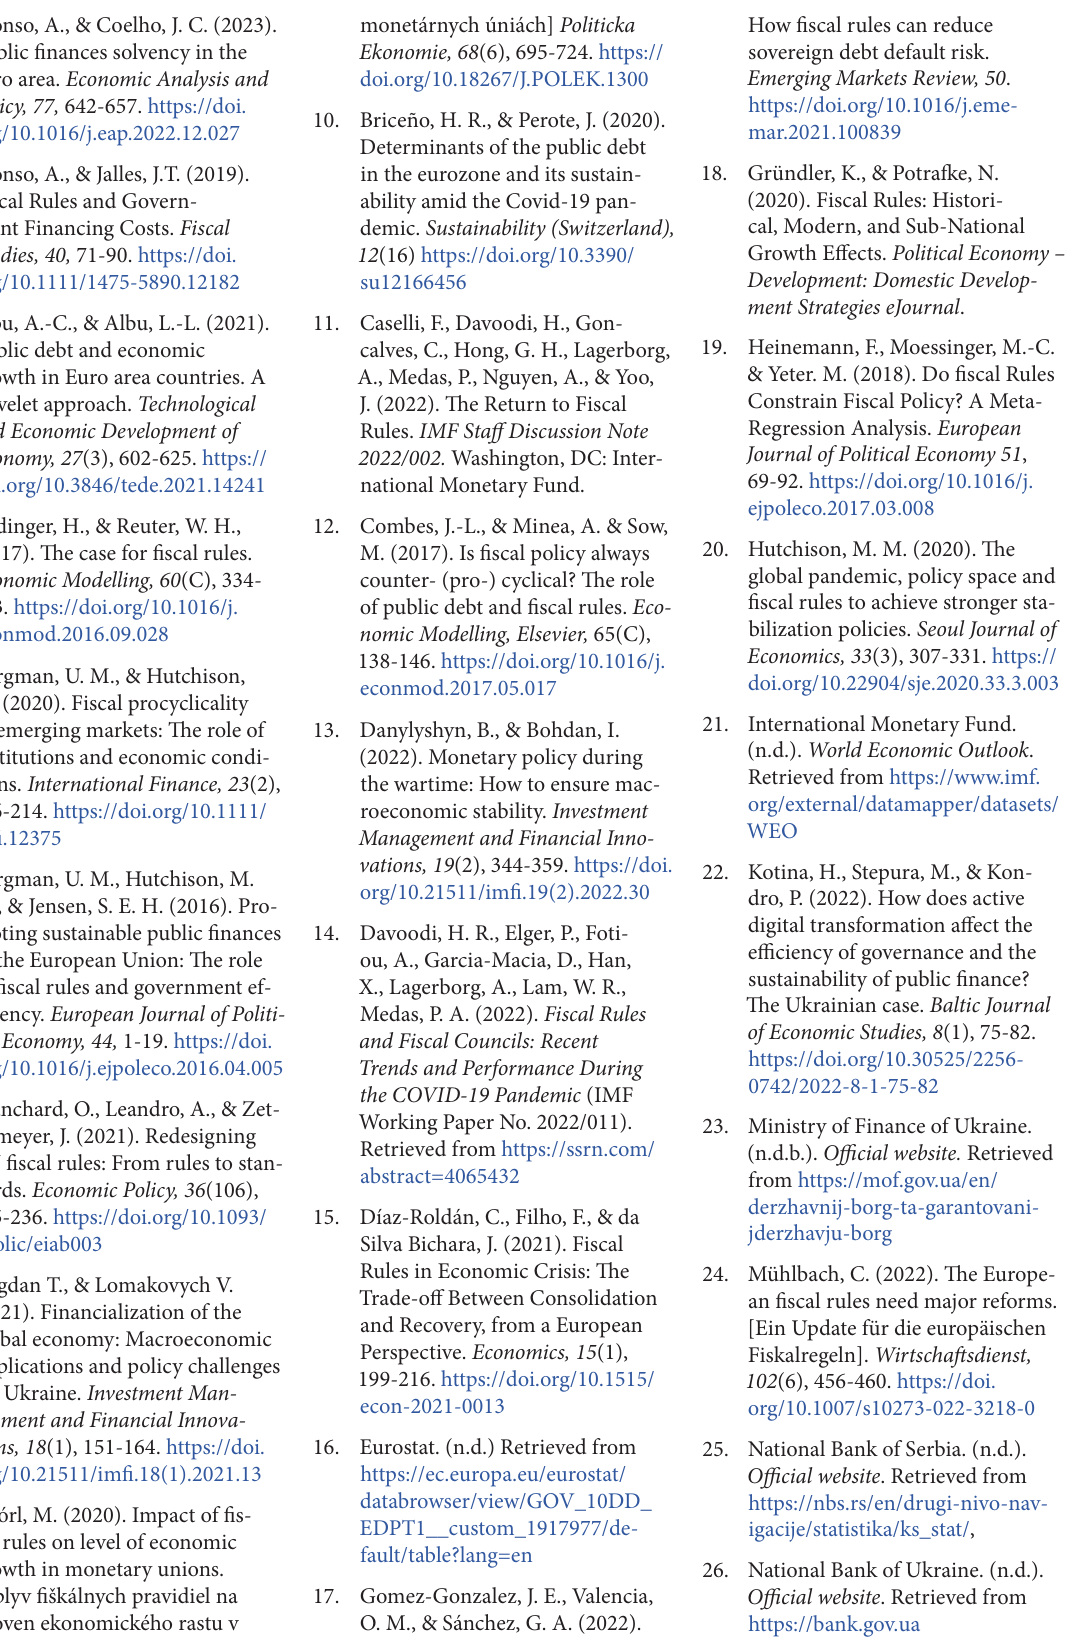
26. National Bank of Ukraine.